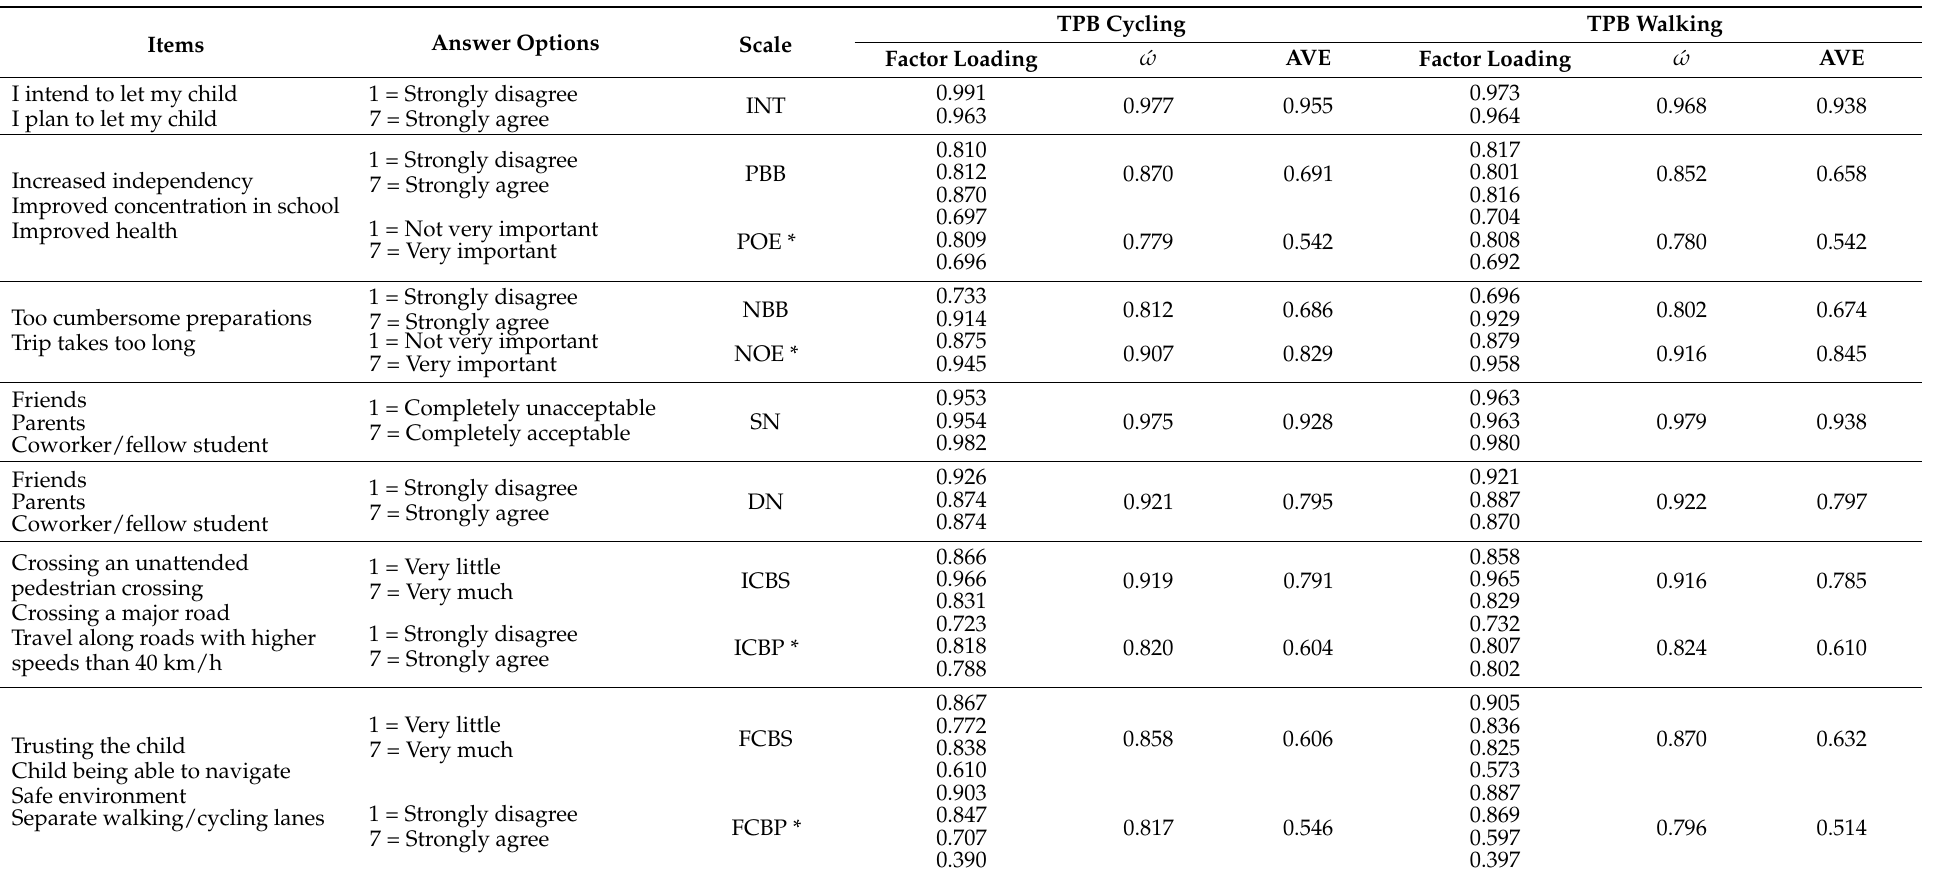
Table 2. Overview of items, CFA factor loadings, McDonald’s Omega and AVE for the TPB cycling and walking